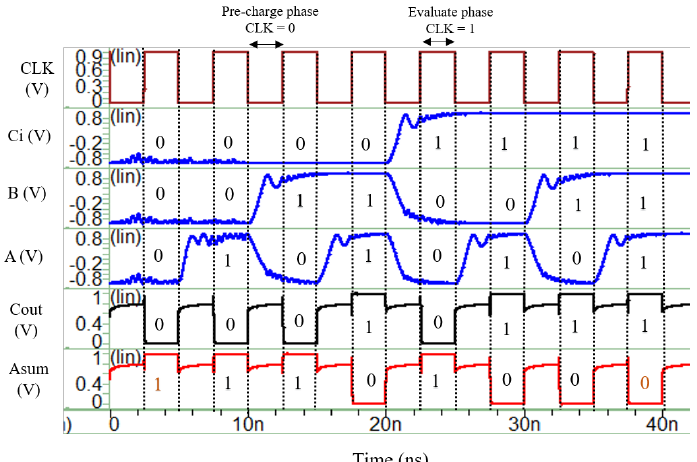
Figure 6. Transient response of arithmetic operation SUM, where CLK is input clock pulse, A and B are input logic values, Ci is carry input values, Cout is the output carry values, and Asum is the approximate sum